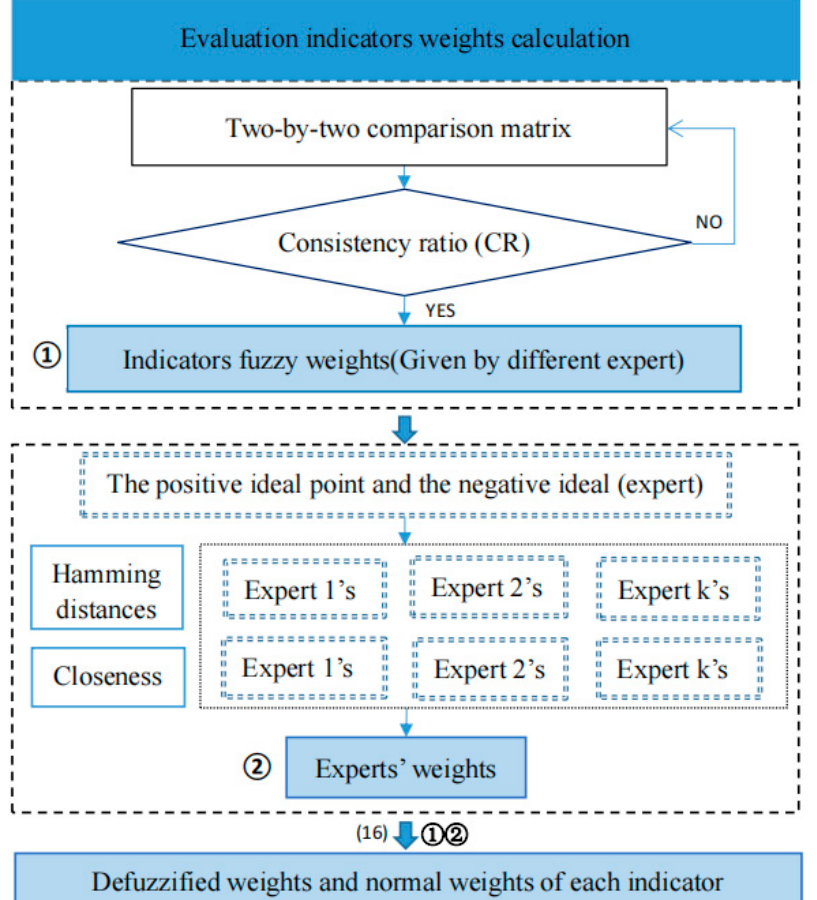
Figure 1. Flow chart for calculating indicator weights.